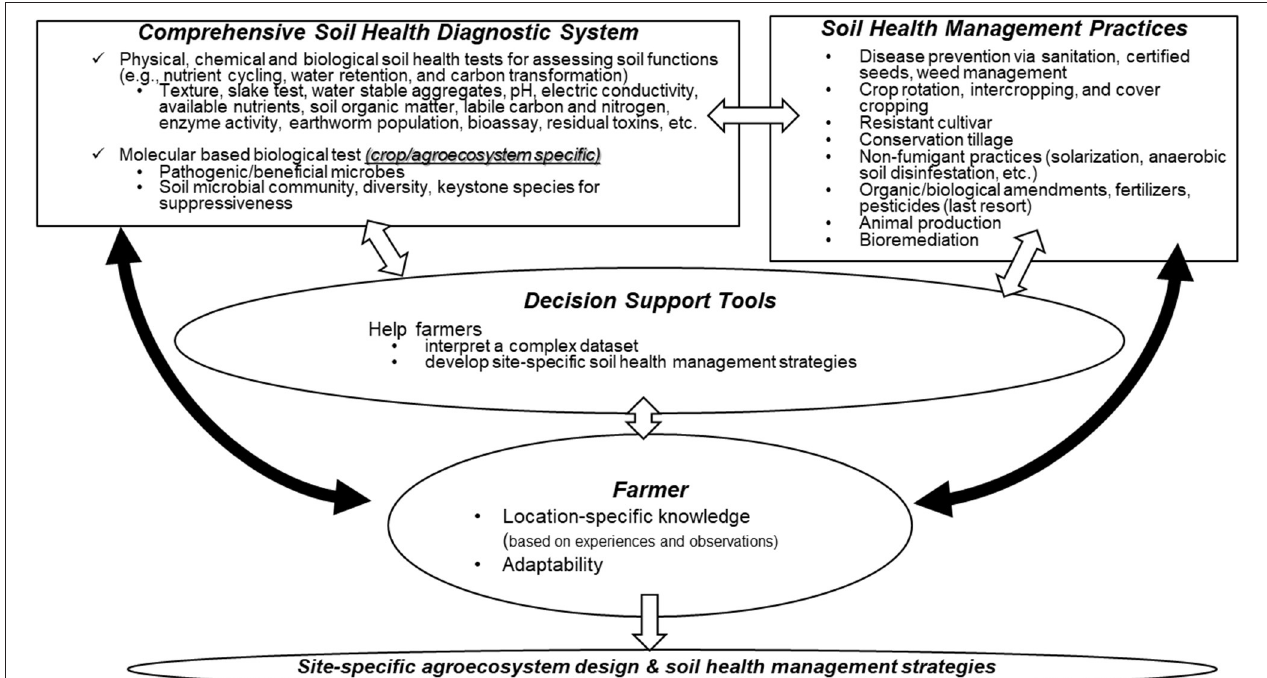
FIGURE 1 | The structure of the integrated soil health management (ISHM) system consists of farmers location-specific knowledge and adaptability, comprehensive soil health diagnostics, a suite of soil health management practices, and decision support tools (optional). Studies on relationships between varying soil health management practices and disease/pest suppression, nutrient uptake, and plant growth will help improve the diagnostic methods and develop actionable thresholds in diagnostics. Rectangular shapes and oval shapes indicate hardware/physical elements and software/intellectual elements of the system, respectively. Roles of decision support tools can be substituted or enhanced by agricultural professionals, consultants, and/or farmer-to-farmer networks (social